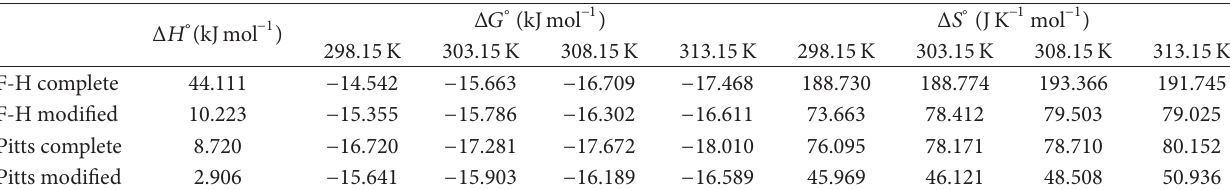
T 12: ermodynamic data for